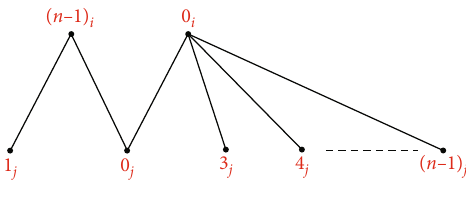
1, 0, n − 3 ÞÞ i , j 3 ð